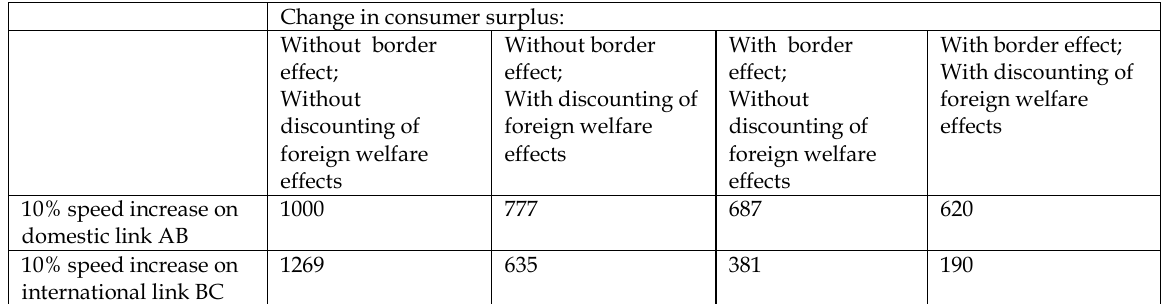
Table 5. Change in consumer surplus owing to investment in domestic versus international link; with and without border effects in transport